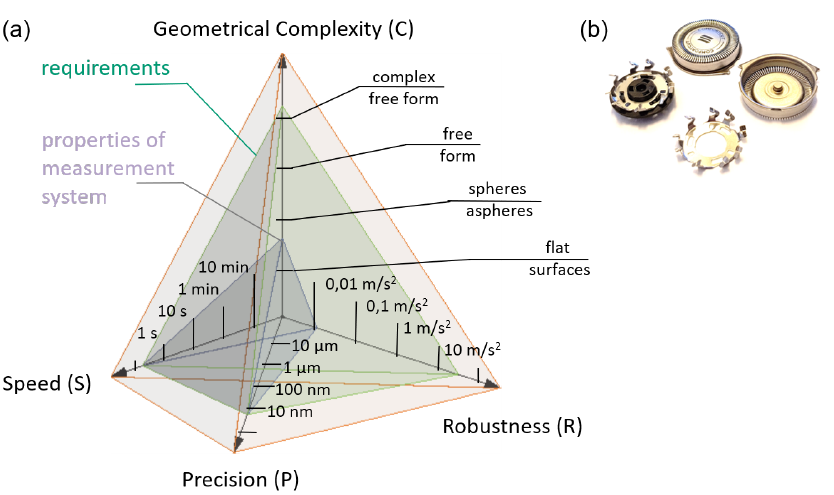
Figure 1. Tetrahedron of optical metrology and its applications: ( a ) Requirements are speed (S), robustness (R), precision (P) and geometric complexity (C) as described in the text. As an example, the small, darker shaded volume shows a measurement system, which may represent a given type of interferometer with high measurement speed, high precision but low robustness suitable for only simple geometric shapes such as flat or near flat surfaces. In contrast, a production process for certain micro-parts may not only require high speed and high precision but may also require a measurement process that allows measuring a complex geometry in the presence of high levels of vibrations as indicated in this scheme by the larger lighter shaded volume. ( b ) Example of complex shaped parts of a commercially available razor. The cap (upper part) has a diameter of approximately one cm. The ensemble consists of three parts with the cap also shown from the inside (on the right).